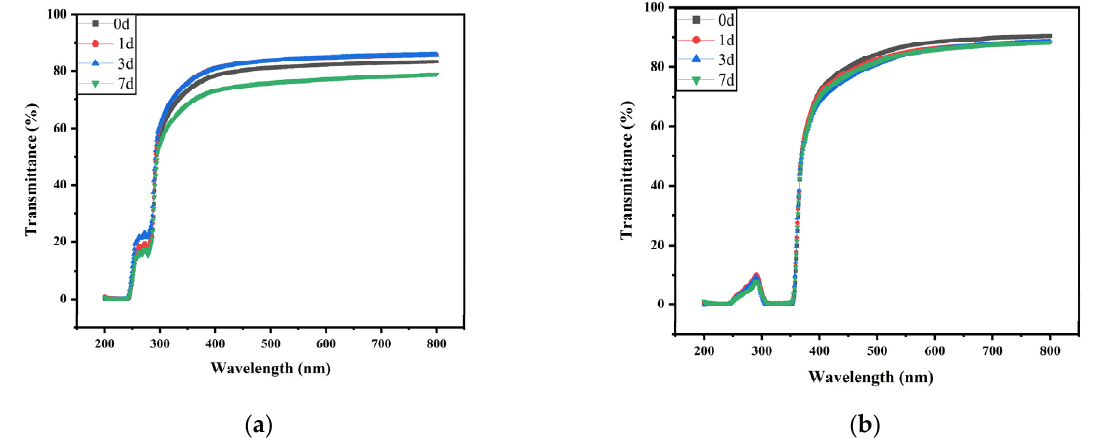
Figure 7. ( a ) Influence of storage time on light transmittance of FSM-0. ( b ) Influence of storage time on light transmittance of FSM-5.